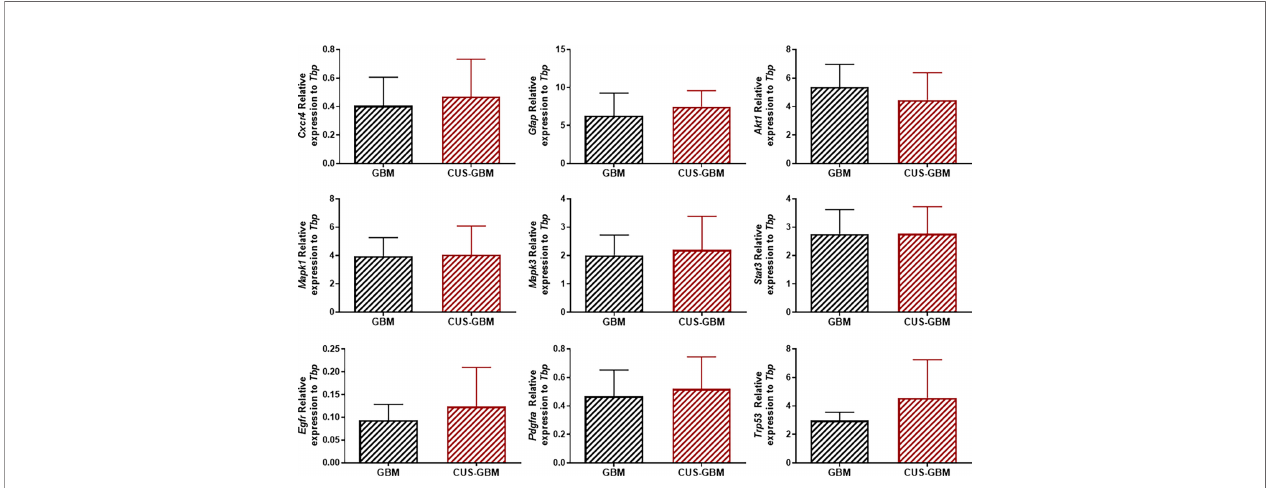
FIGURE 4 | Chronic stress does not affect the expression of several genes in tumor tissue from mice implanted with GBM cells. Quanti fi cation of Cxcr4, Gfap, Akt1, Mapk1, Mapk3, Stat3, Egfr, Pdgfra and Trp53 genes expression in mice unexposed or exposed to CUS protocol in tumor tissues (expression normalized to Tbp ). (GBM, n = 3; CUS-GBM n =